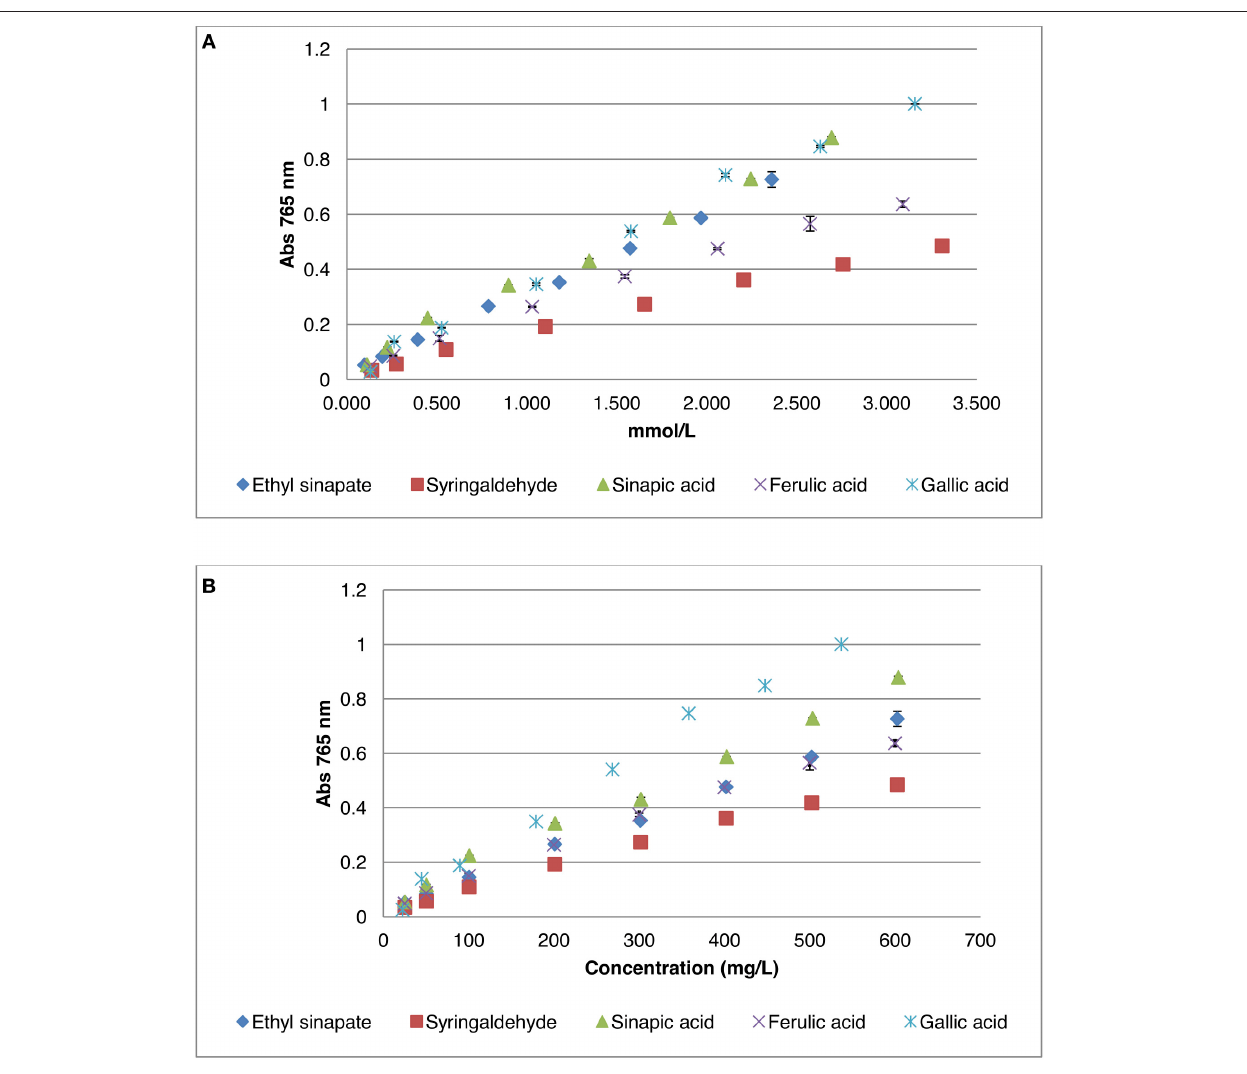
Frontiers in Sustainable Food Systems |